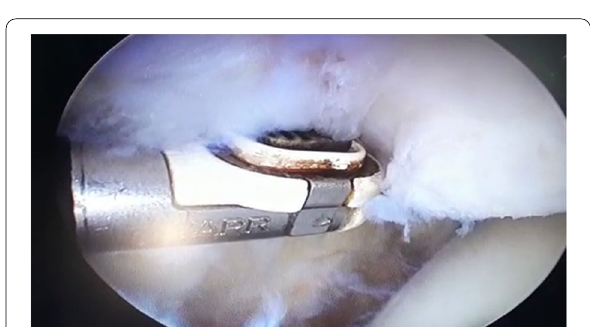
Fig. 6 Arthroscopic patellar denervation technique